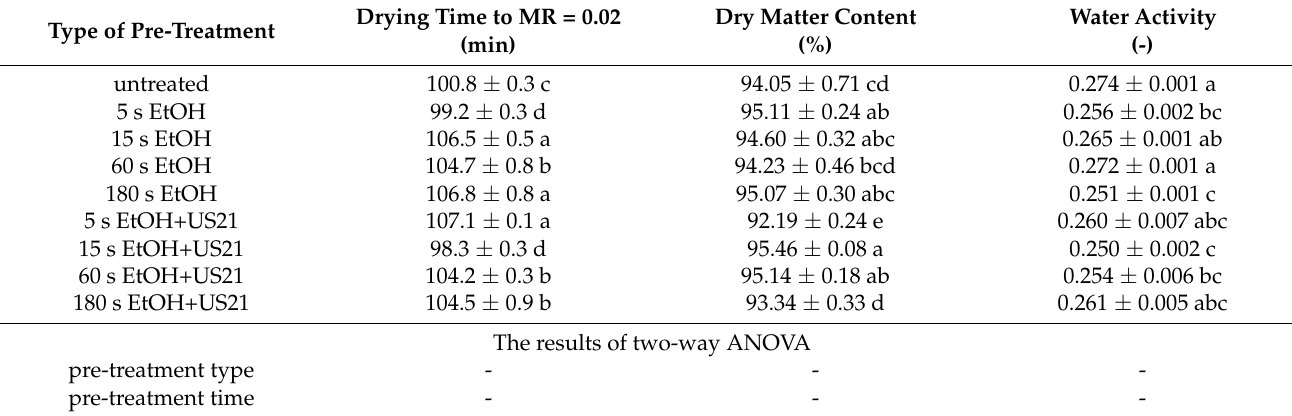
Table 3. Drying time to MR = 0.02, dry matter content, water activity of dried carrot tissue pre-treated without and with ultrasound; error bars indicate ± SD (standard deviation calculated from three repetitions).